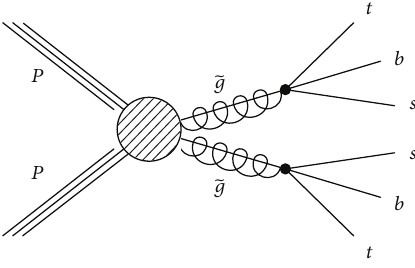
Figure 17: Signal process for ̃𝑔 → 𝑡𝑏𝑠 assuming gluino pair-pro- duction and 𝜆 󸀠󸀠 323